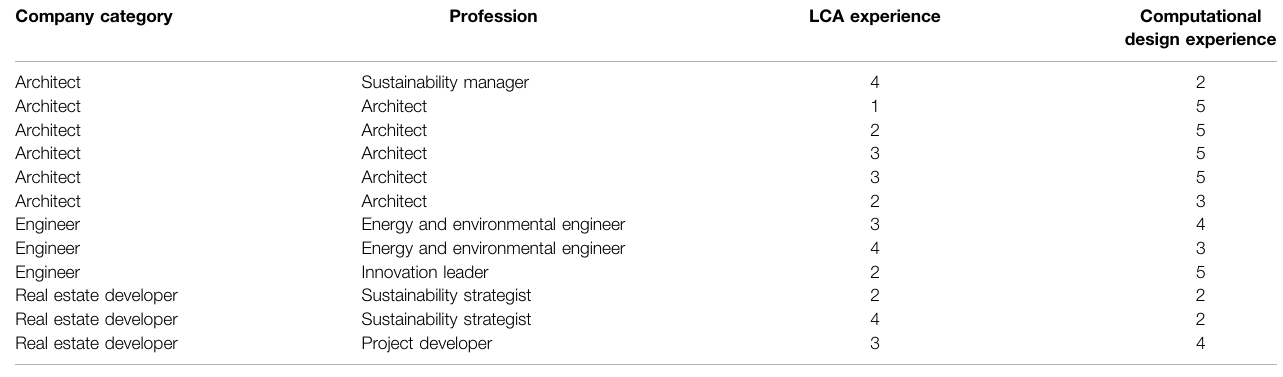
TABLE 2 | Participants in the user tests.